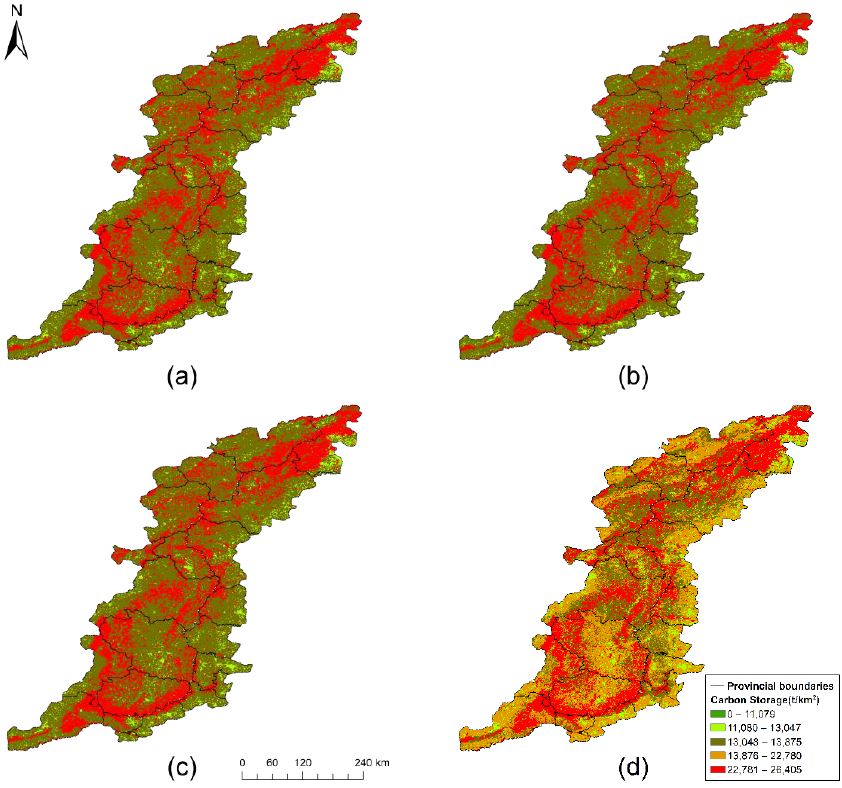
Figure 4. Spatial distribution of carbon storage in the Taihang Mountains in different periods: ( a ) 2005; ( b ) 2010; ( c ) 2015; ( d ) 2019. From the changes in carbon storage of land use types (Table 4), the carbon storage in the Taihang Mountains showed a decreasing trend year by period. From 2005 to 2019, the carbon storage in the Taihang Mountains decreased by −5 .26 × 10 6 t overall, with the most significant decrease of −3 .95 × 10 6 t in 2015 – 2019. In terms of land use types, farmland and grassland decreased by −3 0.87 × 10 6 t and −1 4.24 × 10 6 t during the whole period, respec- tively. Arable land was the main land use type with reduced carbon storage. Forest and construction land increased by 8.27 × 10 6 t and 33.84 × 10 6 t, respectively. Construction land was the land use type with the most significant increase in carbon storage. Table 4. Changes in carbon storage of various land use types in the Taihang Mountains (×10 6 t). Type −2.99 −5.26 Storage Area: Carbon storage by land use type. Pct: Percentage of carbon storage by land use type.